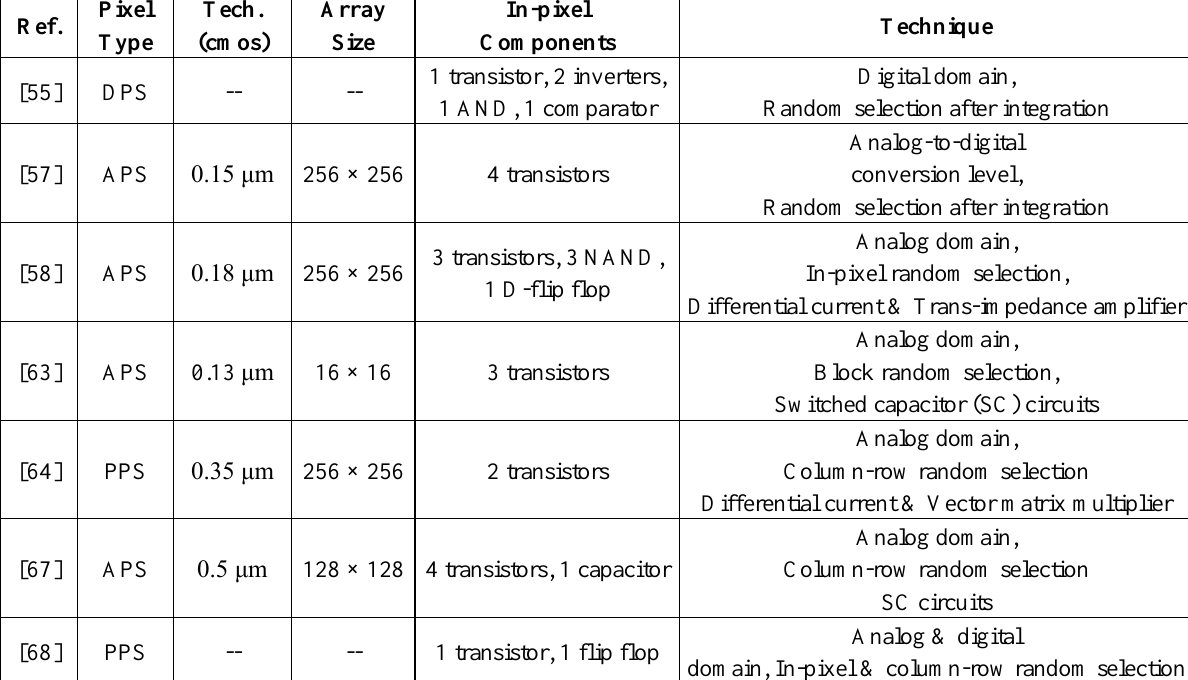
Table 1. Summary of various CS-CMOS imagers available in the literature.